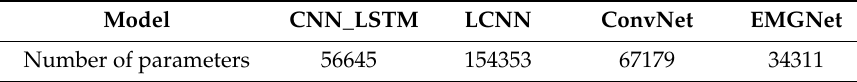
Figure 6. EMGNet Architecture contains four convolutional layers and a max pooling layer without using the full connection layer as the final output. In this figure, Conv refer to Convolution and avg_pool to a max pooling layer. Table 1. Number of parameters used by various models.